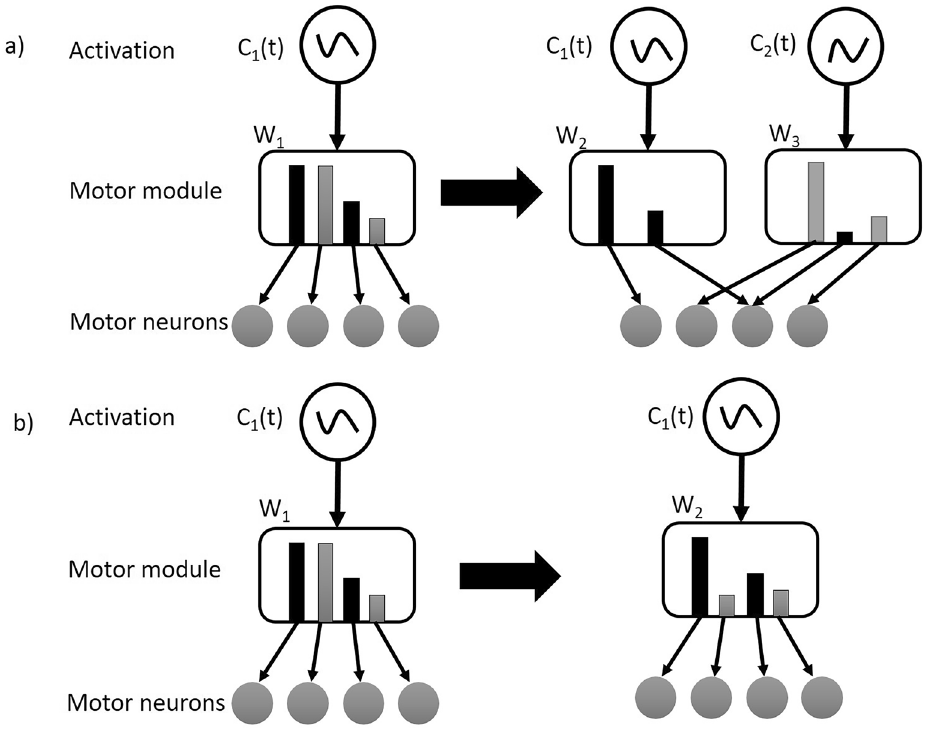
Figure 1. Schematic diagram of the muscle-synergy generation through a) fractionating the pre-existing synergies and b) modifying the weight(s) of pre-existing synergies. Fractionation of synergies could be attributed to the change of oscillator, which generates burst activities at different phases of the gait cycle. The modification of synergies is only related to the synergy-encoding interneurons, which determines the structure of